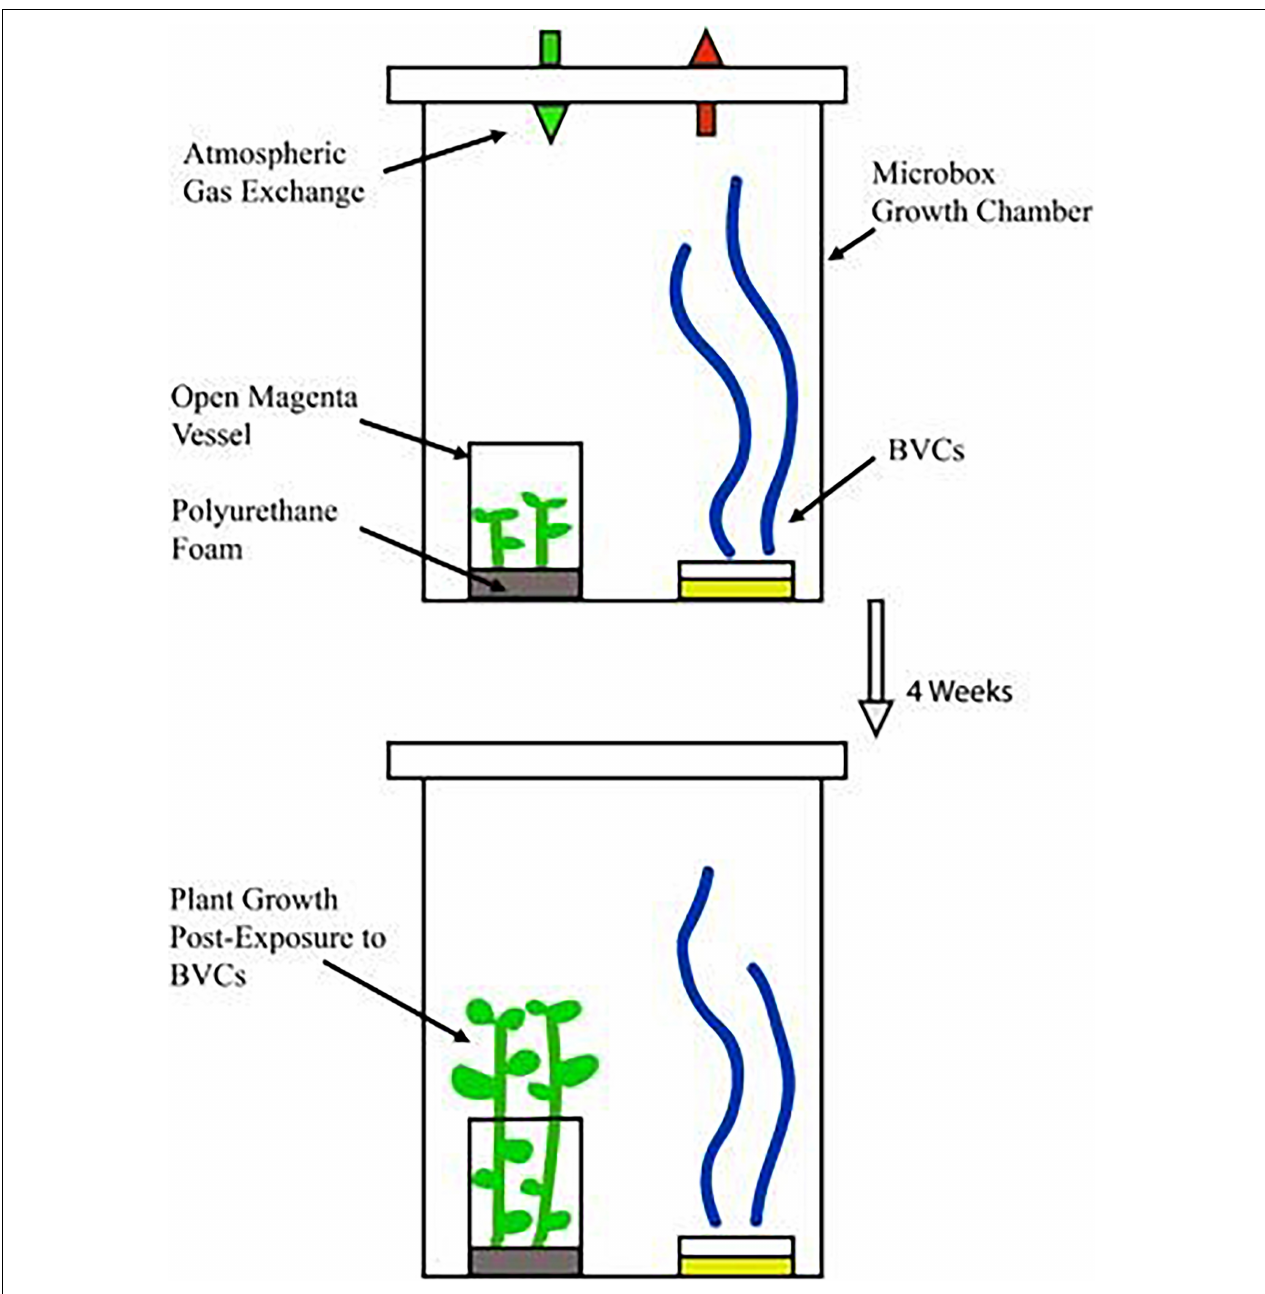
FIGURE 1 | Plants growing in polyurethane foam imbibed with 50 ml M+S media. Bacteria release BVCs from respective growth media and plants are exposed to BVCs within the growth chamber. Gas exchange between the atmosphere and the growth chamber is mediated by the Microbox R (cid:13) growth chamber technology. Plants are co-cultivated with respective physically separated bacteria for 4